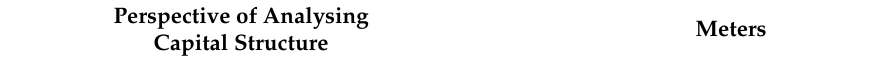
Table 1. Concepts of capital